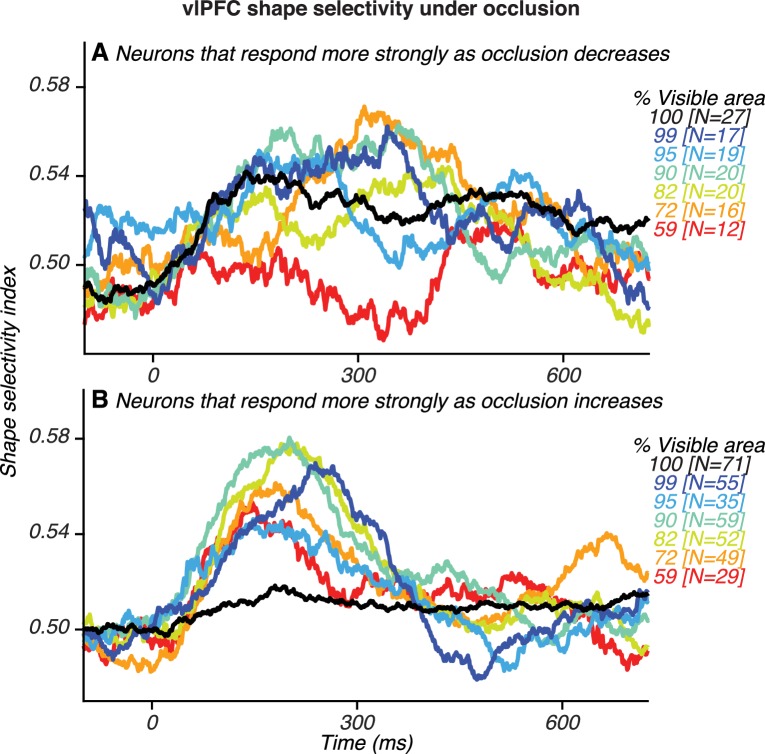
Shape selectivity for two groups of vlPFC neurons.(A) Neurons that responded preferentially to stimuli at lower occlusion levels (higher % visible area). (B) Neurons that responded preferentially to stimuli at higher occlusion levels (lower % visible area). Neurons with a positive slope in Figure 3B contributed to the data in (A) whereas neurons with a negative slope contributed to the data in (B). Two patterns are evident. First, even among vlPFC neurons that responded more strongly to unoccluded stimuli, shape selectivity was not stronger for unoccluded stimuli compared to occluded stimuli. Second, vlPFC neurons that preferred higher occlusion levels also carried more information about the occluded shape.